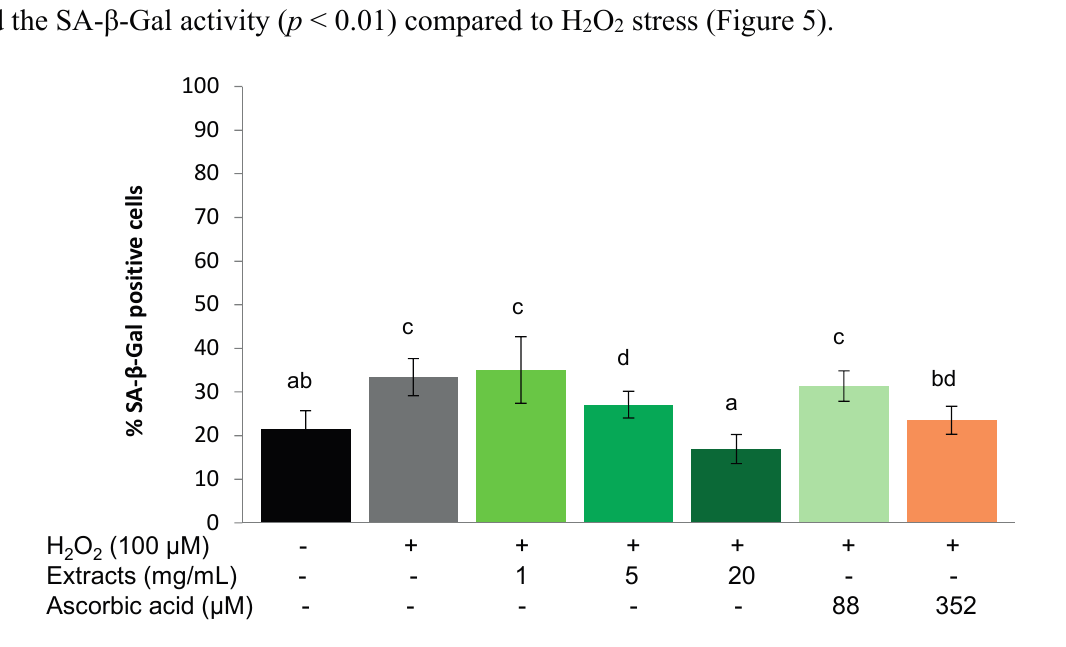
Figure 5. Recovery effect of S. oleraceus leaf extracts on H 2 O 2 treated WI-38 cells. Cells were treated with 1, 5 or 20 mg/mL S. oleraceus leaf extracts or 88 or 352 µM ascorbic acid for 1 h following a 1 h incubation with 100 µM H 2 O 2 as exogenous stress. Data are shown as percentage of SA- β -Gal positive cells (mean ± SD, n = 6). Bars with no letters in common are significantly different ( p < 0.05) .